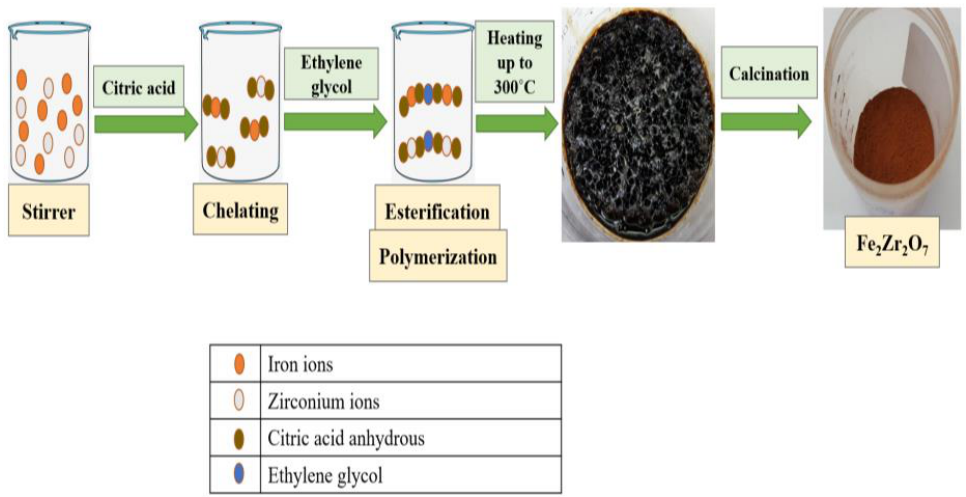
Figure 10. Pechini procedure for preparation of Fe 2 Zr 2 O 7 photocatalyst.